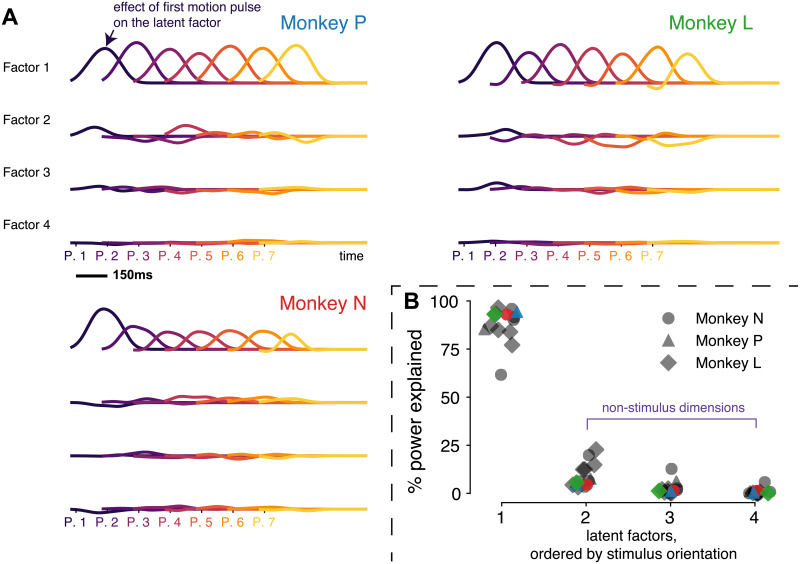
Visual motion pulse information encoded in one dimension.(A) Pulse-triggered average of three example sessions, one from each monkey, are shown. The factors are rotated such that most of the stimulus power is in the first factor. They visualize the weights of pulses on the latent factors that were estimated from respective sessions. The color gradient indicates the seven pulses of visual motion stimuli. Each pulse last 150ms. (B) The power of each factor that explains the variation contributed by the stimuli to the factors. Each marker indicates one session, the shape indicates the animal and the color indicate the respective example sessions in (A).